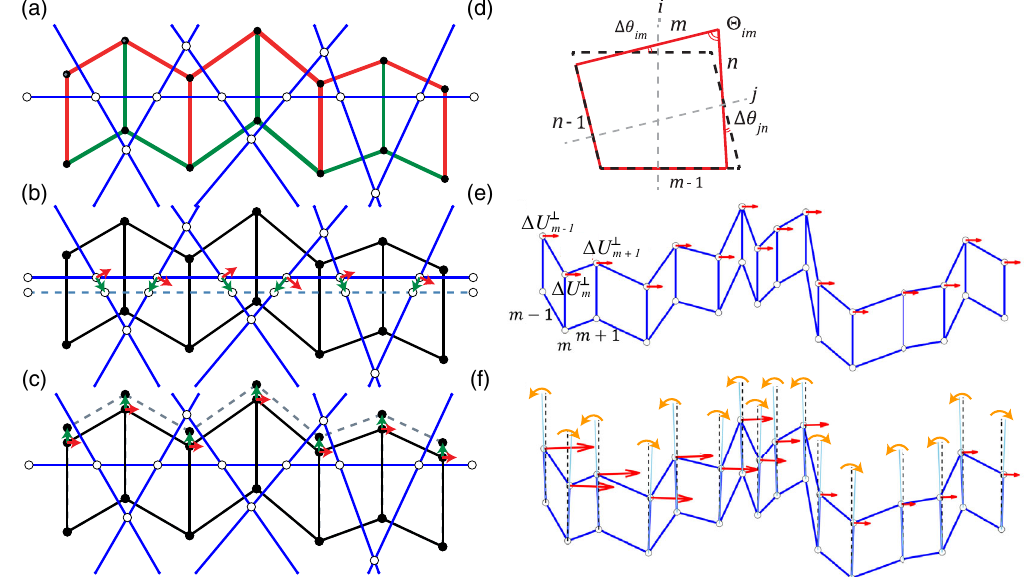
FIG. 4. The reciprocity relation between parallelogram tilings and fiber networks. (a) A strip in a parallelogram tiling carries a SSS (sign of tension shown by red and green colors and magnitude shown as edge thickness). Linear combinations of these SSSs from different strips lead to its reciprocal fiber network (blue lines with white cross-linking nodes). (b) A different linear combination of SSSs of the parallelogram tiling leads to a different fiber network, which is parallel to other fiber networks that are reciprocal to the same parallelogram tiling. (The definition of the parallel relation between diagrams is introduced in Appendix D.) Green and red arrows show irrotational and FM displacements ⃗ v and ⃗ u relating these fiber networks, respectively. (c) Similarly, different linear combinations of SSSs of a fiber network lead to different parallelogram tilings that are parallel to one another. (d) Illustration of the dual transfer matrix at a quadrilateral (red solid lines). Gray dashed lines show the corresponding fibers of the strips i and j that cross at this quadrilateral. Black dashed lines denote the corresponding parallelogram where Δ θ i;m ¼ Δ θ j;n ¼ 0 . (e) A strip i of parallelograms carries a bulk FM where Δ U ⊥ i;m (red arrows) is the same at every vertical edge. (f) After small rotations of every vertical edge in directions such that Δ θ Θ < 0 at each modified parallelogram (black dashed lines show the vertical direction, light blue solid lines show extended i;m cot i;m direction of the rotated edges so the rotation is more visible, and orange arrows show the direction of rotation), the FM decays from left to right, as determined in Eq.